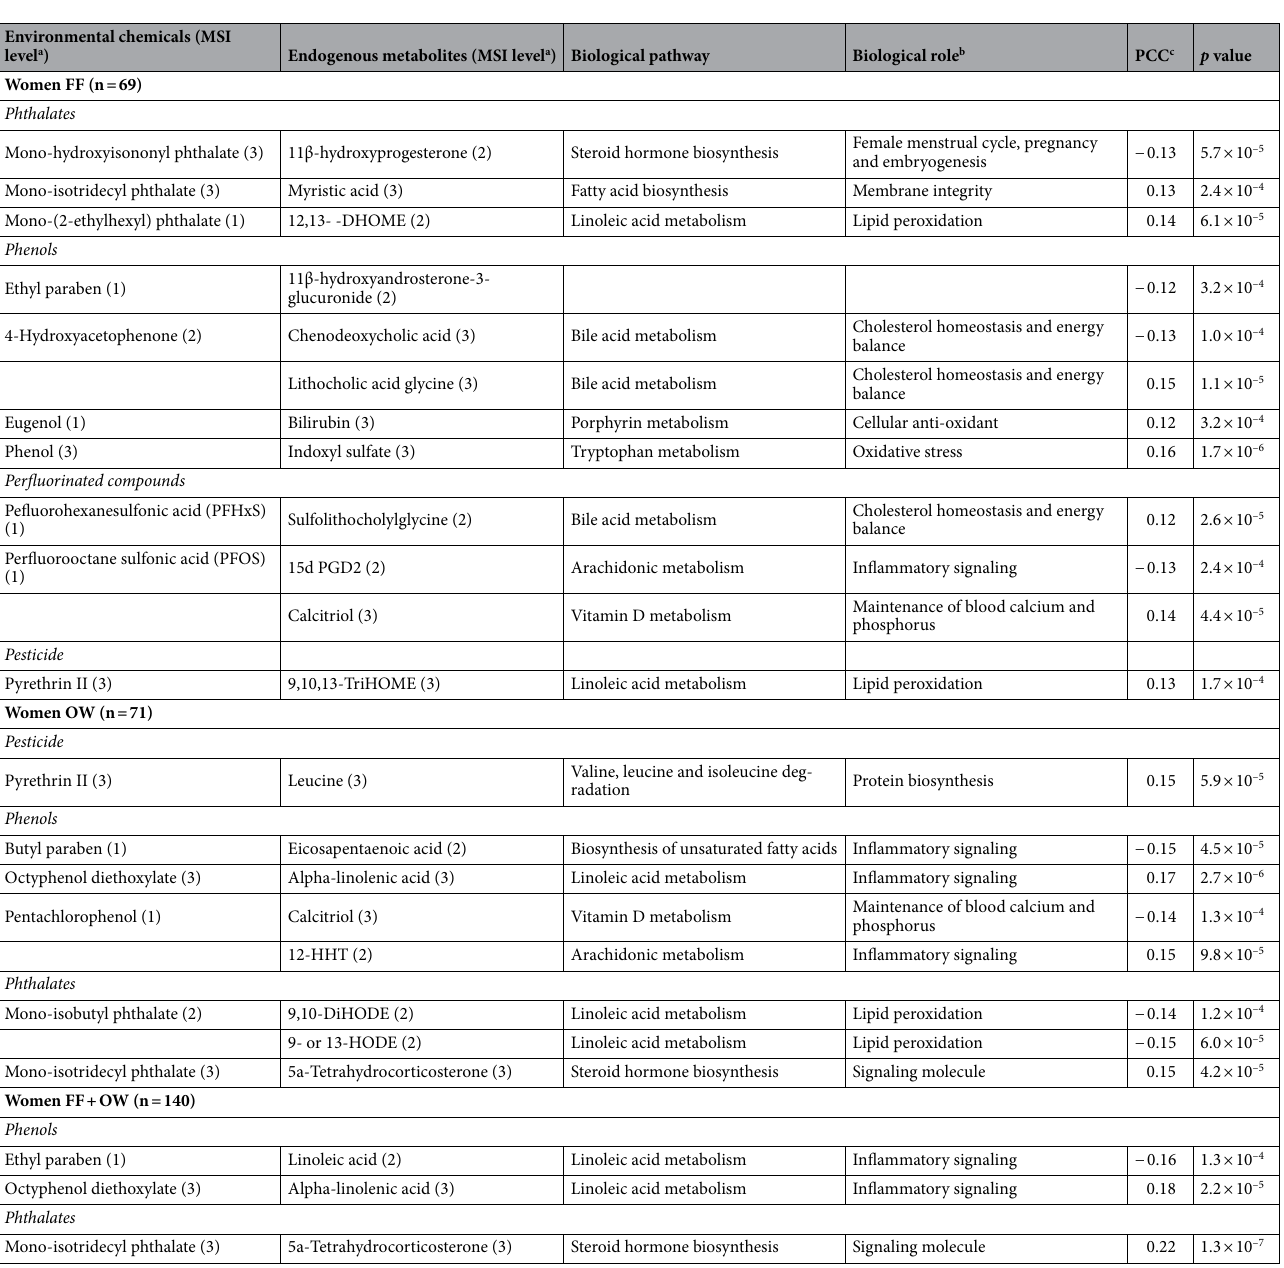
Table 1. Summary of chemical-metabolite associations, biological changes and biological role of metabolites. a Metabolomics Standard Initiative (MSI) level of identification; level 1: match based on accurate mass (± 10 ppm), fragmentation pattern and retention time with authentic standards; level 2: match based on accurate mass (± 10 ppm) and fragmentation pattern using mass spectra from public metabolomics libraries or in-silico fragmentation software; level 3: match based on accurate mass (± 10 ppm) only. b Biological role of metabolite was inferred from the Metab2MeSH web application that annotates compounds with MeSH terms and HMDB database. c Partial correlation